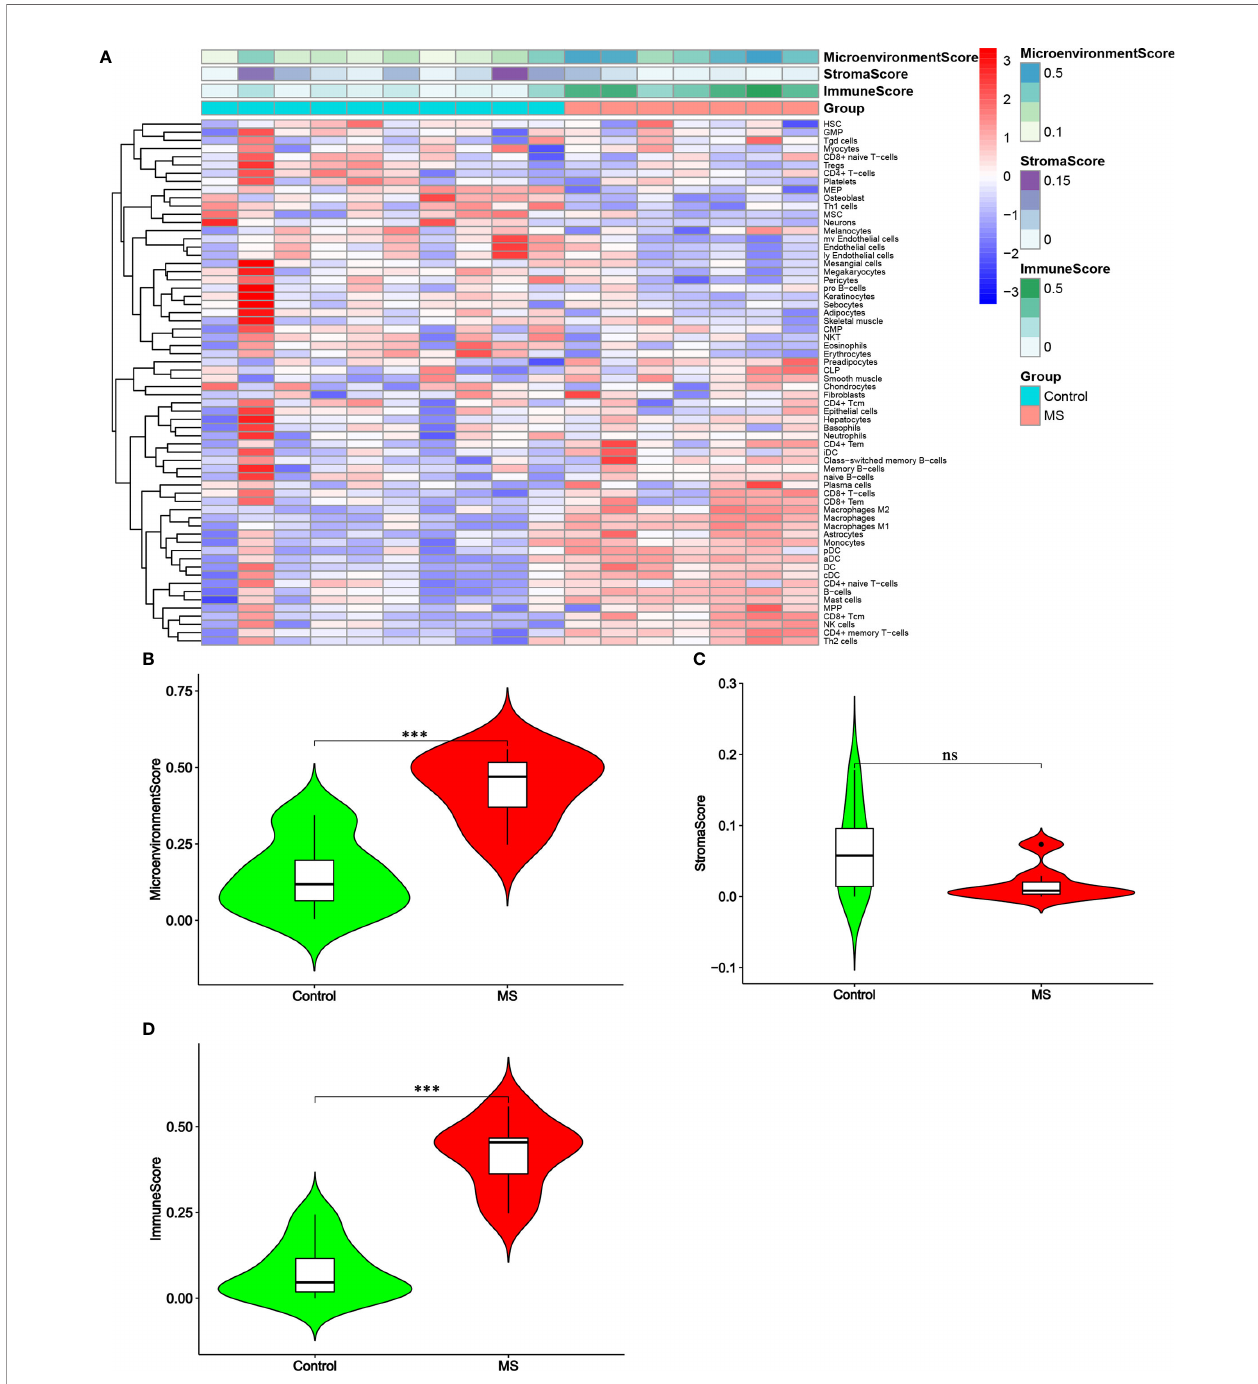
FIGURE 1 | Distribution of immune cells and stromal cells in MS and control groups. (A) Heatmap of normalized absolute abundance for each cell type in every single sample. (B – D) Micro-environment Score, Stroma Score and Immune Score of the samples. Green represents the control group and red represents the MS group. ***P < 0.001. ns, not signi fi